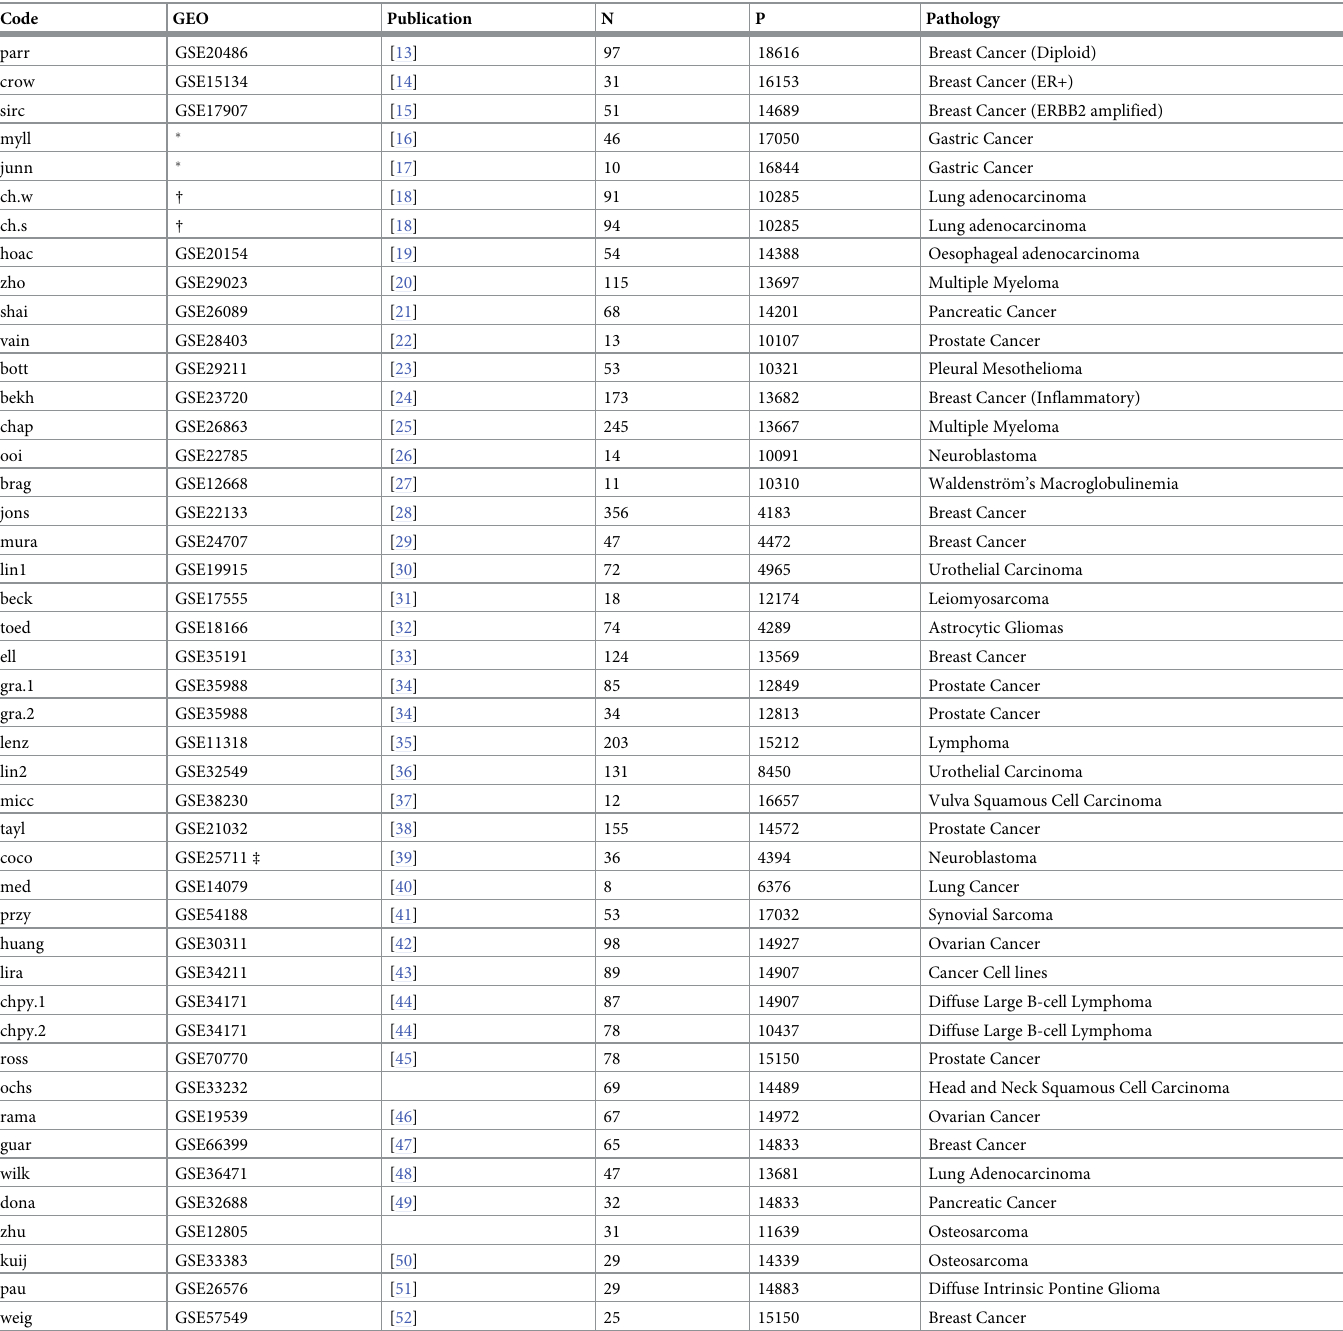
Table 1. Details of the 45 datasets used in the meta-analysis, the original 31 followed by the 14 new datasets.